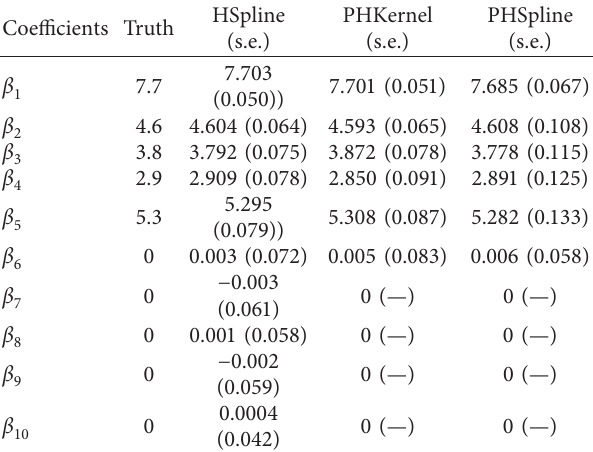
Table 4: Simulation result of Example